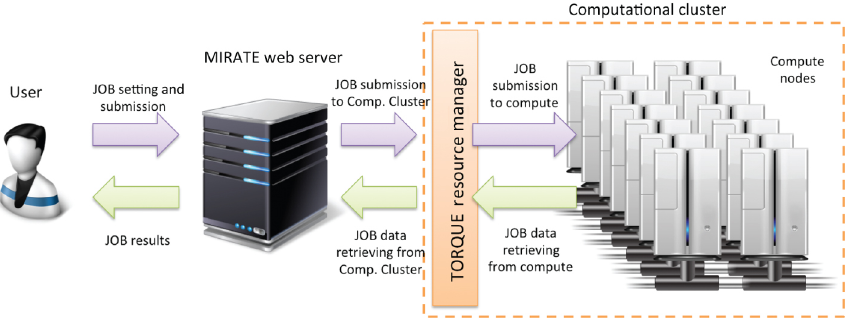
Figure 2: Overview of the MIRATE SW/HW architecture. The local cluster is equipped with TORQUE/PBS Resource Manager (http://www.adaptivecomputing.com/products/open-source/torque/), used to distribute and